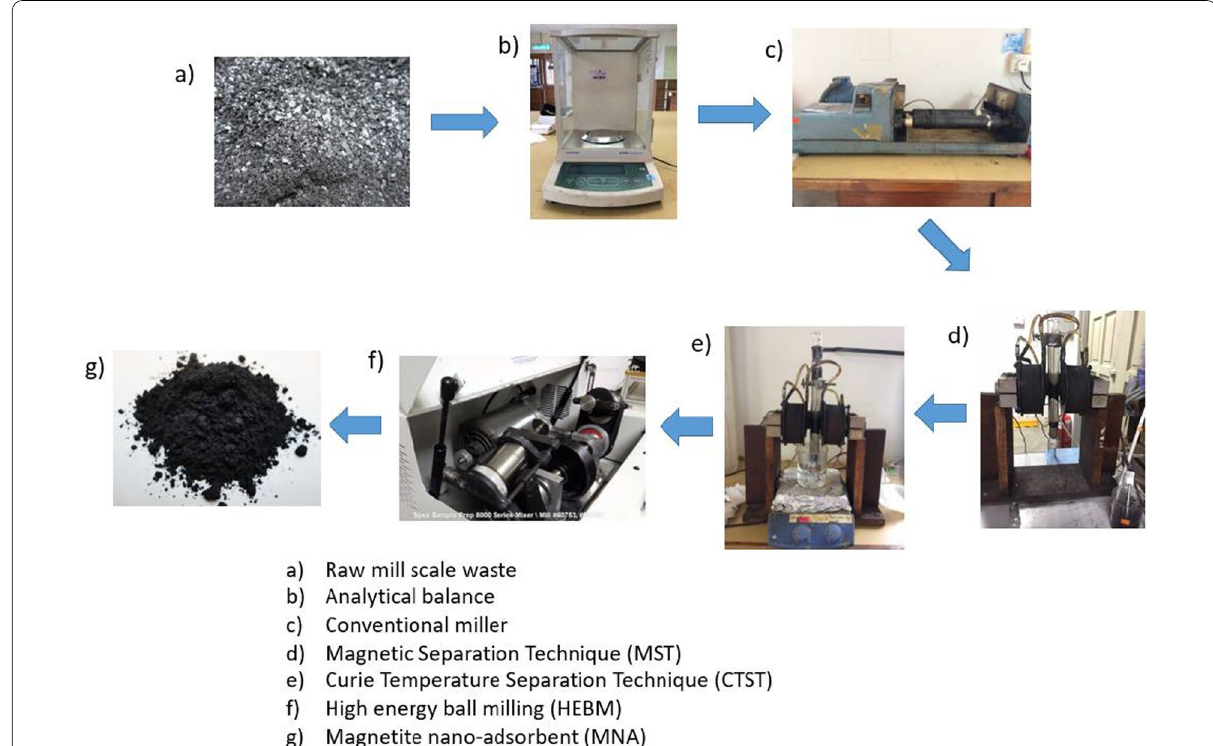
Fig. 1 Synthesis procedure of magnetite nano-adsorbent using HEBM